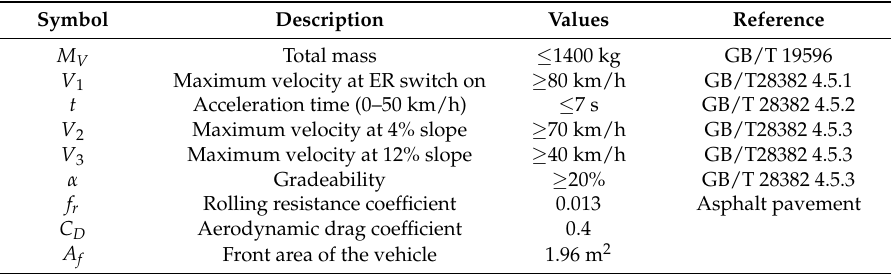
Table 1. Required EREV performance